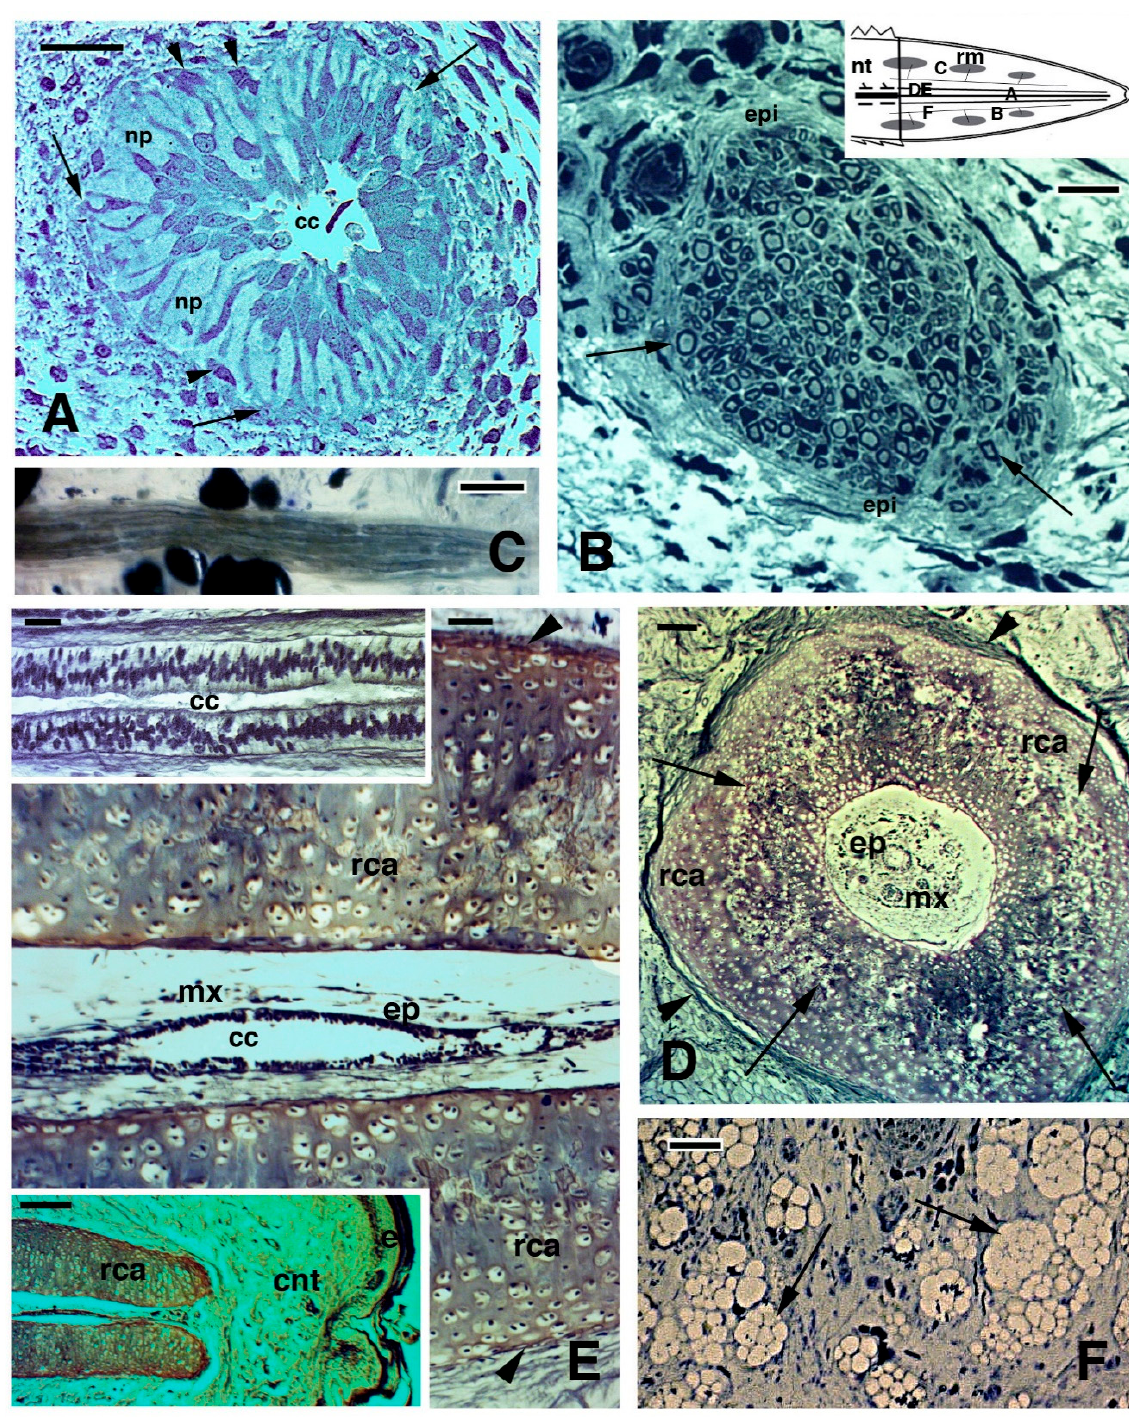
Figure 5. Histology of regenerating tail ( A , B , F ) Toludine blue stain; ( D , E ) Palmgreen stain). ( A ) cross-sectioned ependymal tube showing the elongation of ependymal tanicytes ending on the basement membrane (arrows). Arrowheads point to glial cells detached from the ependymal epithelium. Bar, 10µm. ( B ), cross-sectioned myelinated (arrows) nerve at 10 months regeneration. Bar, 10µm. The schematic drawing shows the indicated positions of the figures. ( C ), longitudinal section of myelinated nerve 10 months post-autotomy. Bar, 10µm. ( D ), cross section of the cartilaginous tube in a long regenerated tail of unknown age. Arrows indicate intra-cartilaginous areas of calcification/degeneration. Arrowheads indicate the fibrous connective contacting the perichondrium. Bar, 50µm. ( E ) longitudinal section of axial cartilage in an old regenerate of unknown age. The outer perichondrium is indicated by arrowheads. Bar, 20µm. The upper inset (Bar, 10µm) details the pseudostratified ependymal epithelium. The lower inset (Bar, 50µm) instead shows the apical end of the cartilaginous tube, close to the connective tissue of the tip of the regenerated tail. ( F ), numerous fat cells (arrows) are